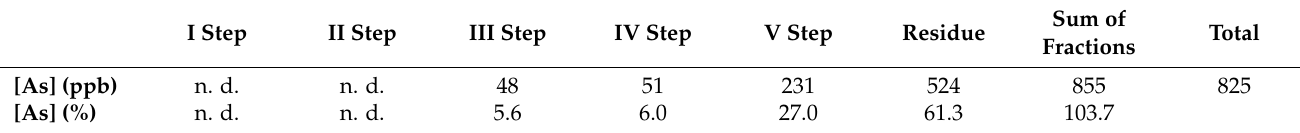
Table 5. Results for the sequential extractions of the As for the coal samples of the Federico II power plant. The values are reported in ppb ( µ g/kg dry weight) and as percentage of the total extracted